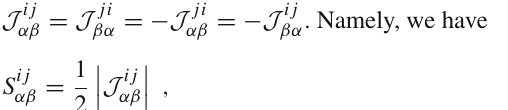
Fig. 5 Three sub-triangles (cid:10) ij αβ of a given unitarity polygon with definite α and β flavor indices, formed by two vectors U α i (cid:4)= j ) in the complex